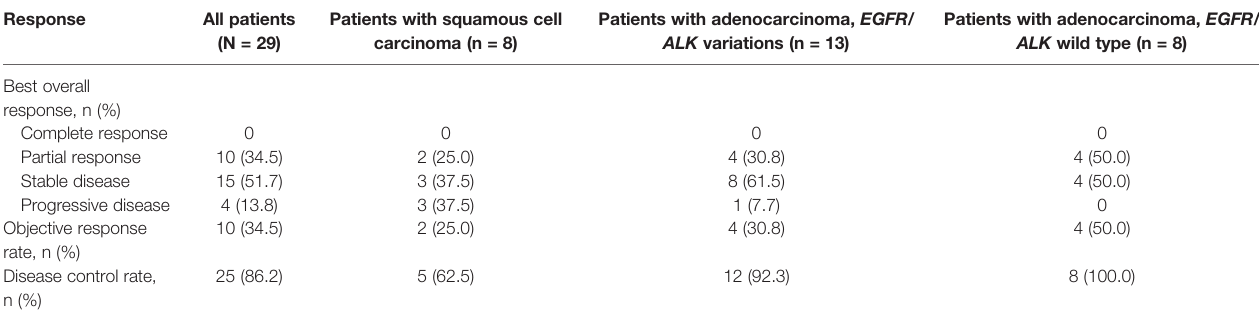
TABLE 2 | Response to treatment.